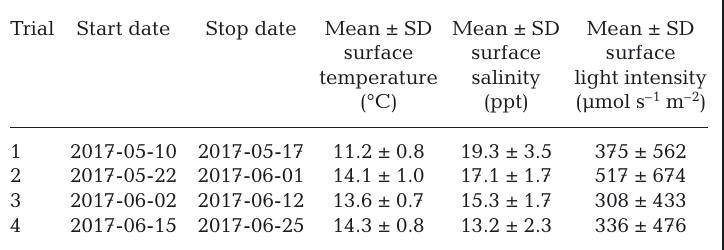
Table 1. Key environmental information for the 4 trials. Temperature and salinity data were sampled throughout the whole study period at 0.2 m depth using loggers. Light measurements were downloaded from a meteorological station (University of Bergen, Norway). Dates are